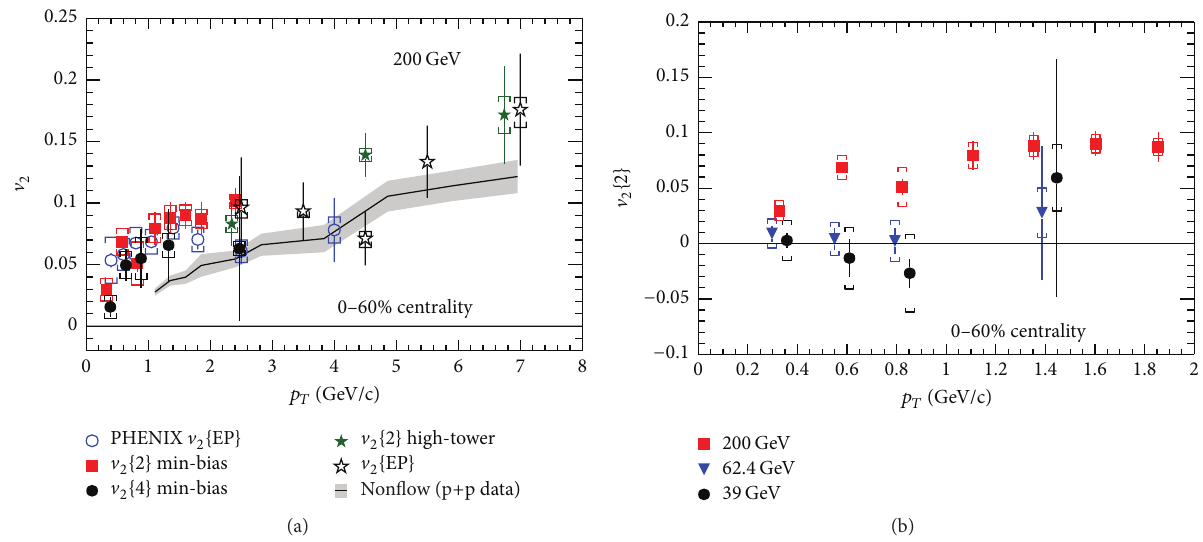
Figure 2: (a) Comparison of azimuthal anisotropy of NPE at √𝑠 NN = 200 GeV measured by PHENIX [20] and STAR [21]. (b) NPE V 2 using two-particle cumulant method at 200 and 62.4 and 39 GeV. The error bars represent the statistical uncertainty and the brackets represent the systematic uncertainties.